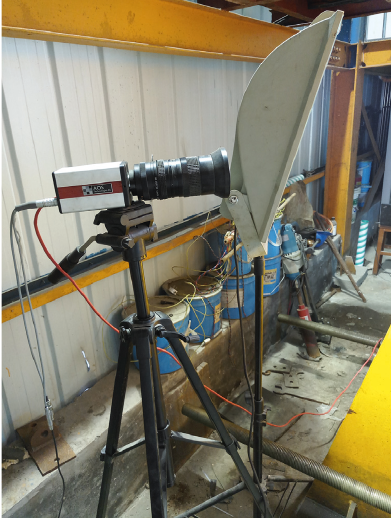
Figure 6: High-speed camera.